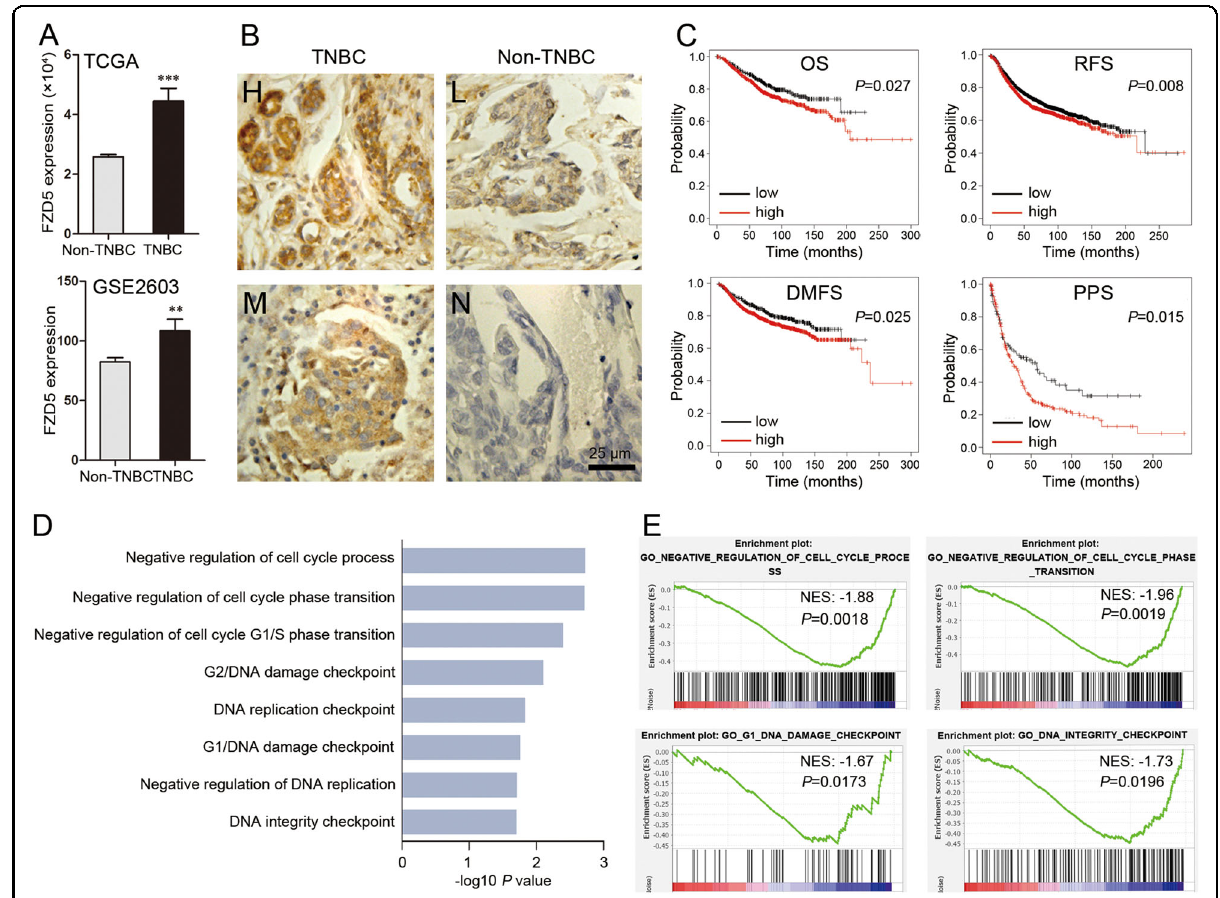
Fig. 1 FZD5 is principally expressed in TNBC and associated with unfavorable prognosis. A TCGA (TNBC: 115; non-TNBC: 858) and GSE2603 (TNBC: 25; non-TNBC: 71) databases were interrogated for FZD5 expression. FZD5 mRNA levels were compared between TNBC and non-TNBC. ** P < 0.01, *** P < 0.001, vs. non-TNBC. B FZD5 expression in 18 TNBC and 24 non-TNBC was detected by immunohistochemistry. Staining of some representative samples was shown. H: high; M: median; L: low; N: negative. Scalebar: 25 μ m. C The association of FZD5 with OS, RFS, DMFS, and PPS was analyzed in Kaplan – Meier plotter website. D , E Go analysis of the gene pathways differentially expressed between FZD5-high and FZD5-low breast cancer samples in TCGA database was performed. Four representative GSEA-enrichment plots were